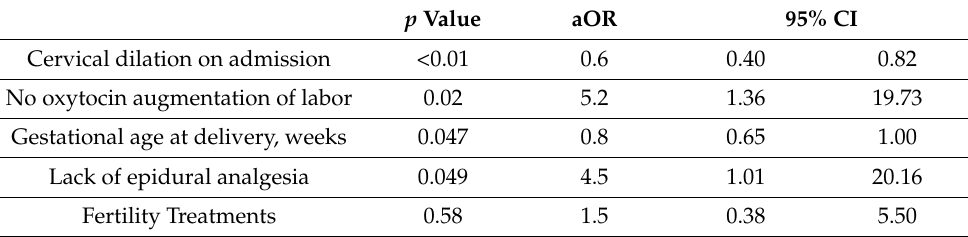
Table 4. Multivariate logistic regression analysis for the association between labor and delivery characteristics and failed TOLAC (Adjusted Odds